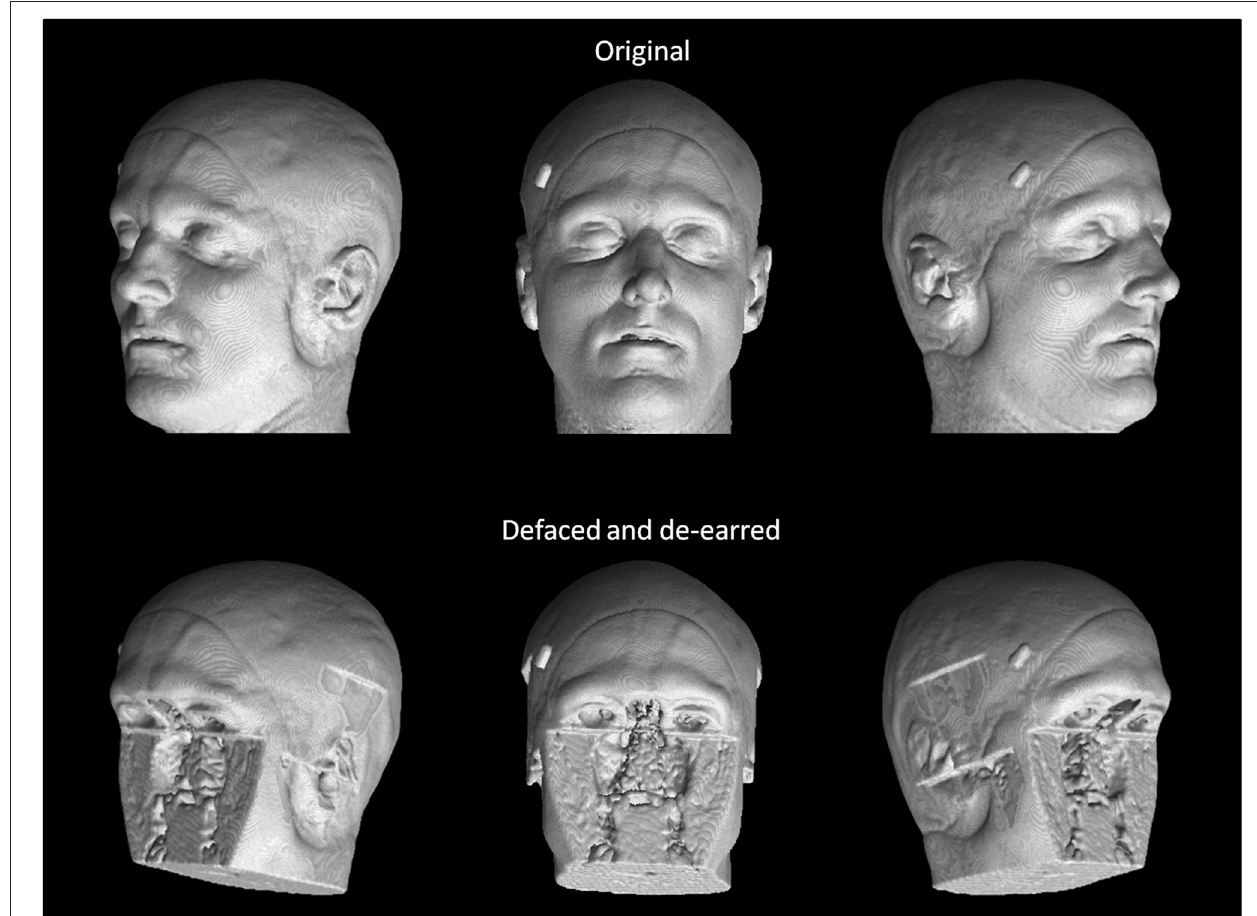
FIGURE 1 | True facial recognition task images. Top row: Sample original (pre-defaced) 3D rendered T1 image. Three perspectives of the head were generated, including 45 ◦ left, straight on, and 45 ◦ right. Bottom: The same image after undergoing defacing (in this case, pydeface) and de-earring. Consent was given by the participant to include their non-defaced MRI render in the